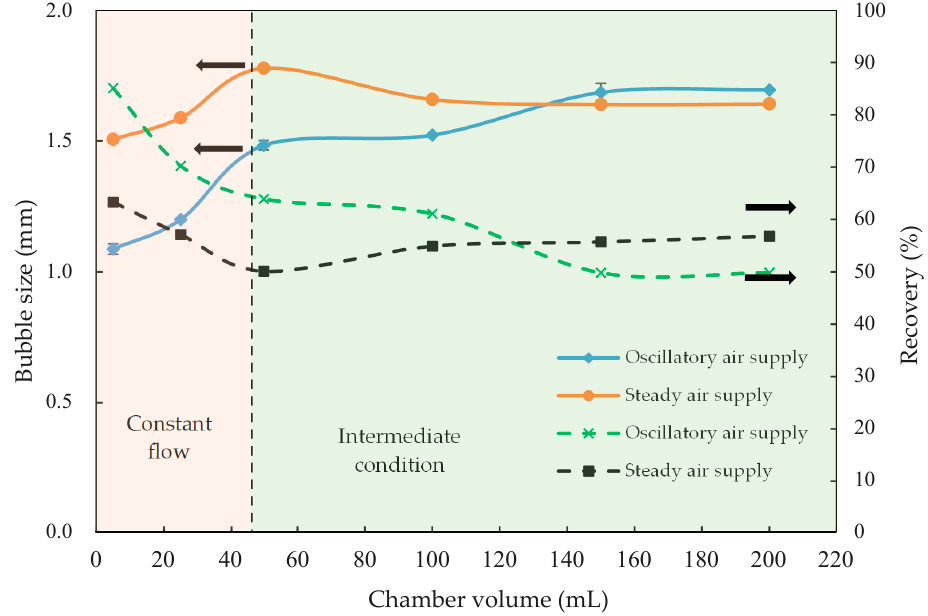
Figure 2. Effects of chamber volume on bubble size and flotation recovery.